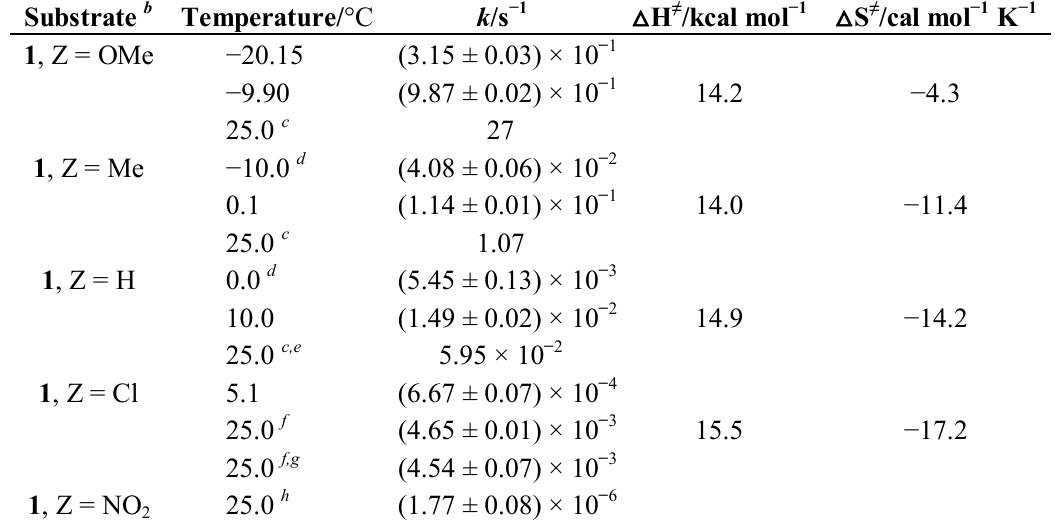
Table 1. Rate constants ( k ) and activation parameters for solvolyses of p -substituted